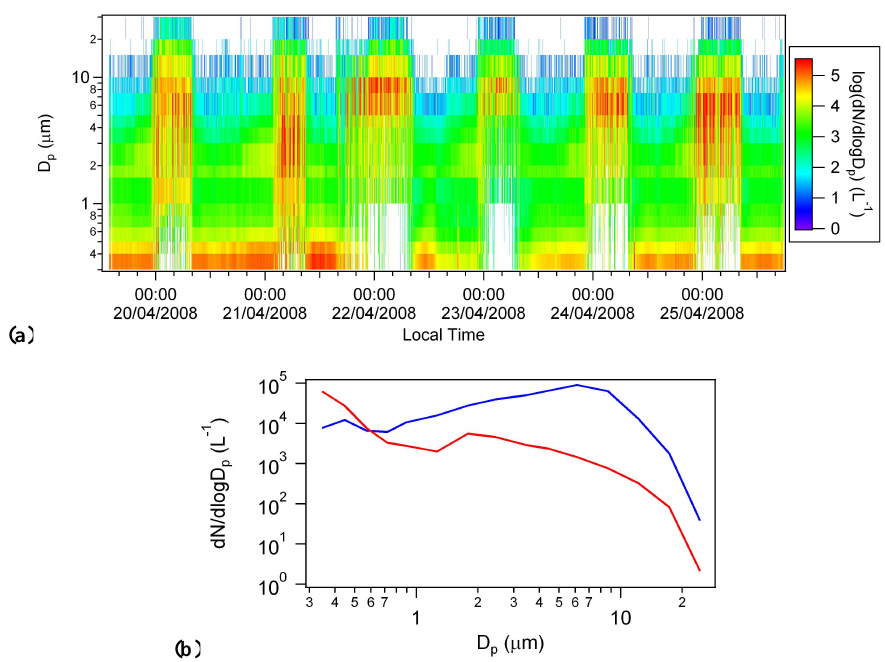
Fig. 6. (a) Time-series of size distributions measured with the GRIMM OPC on the 16m platform within the canopy. (b) The size distribu- tions averaged over this time-series for periods of fog (blue) and no fog